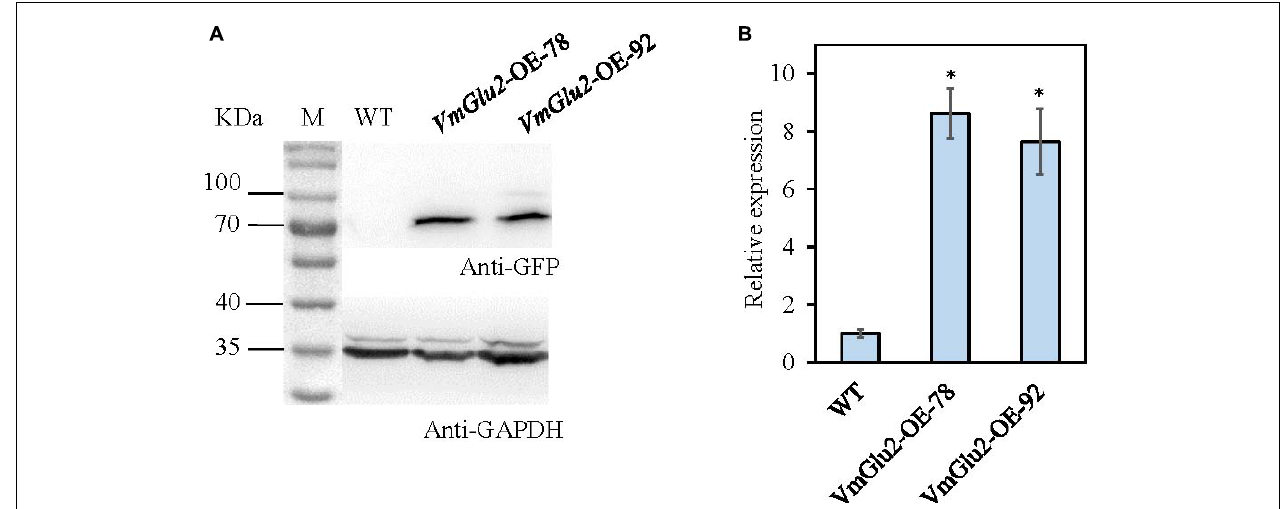
FIGURE 6 | The verification of gene overexpression. (A) Western blot analysis of overexpressed VmGlu2 fused to the GFP-tag in the transformants grown in PDB (PDA without agar) for 2 days. The expression of GAPDH in V. mali was used as an endogenous control. (B) Expression level of VmGlu2 in the VmGlu2 overexpression (OE) transformants in apple twigs at 48 hpi. The expression level of VmGlu2 in the apple bark tissues inoculation with the WT at 48 hpi was normalized to one. Asterisks represent significant differences ( P < 0.05) in the expression level relative to that in the